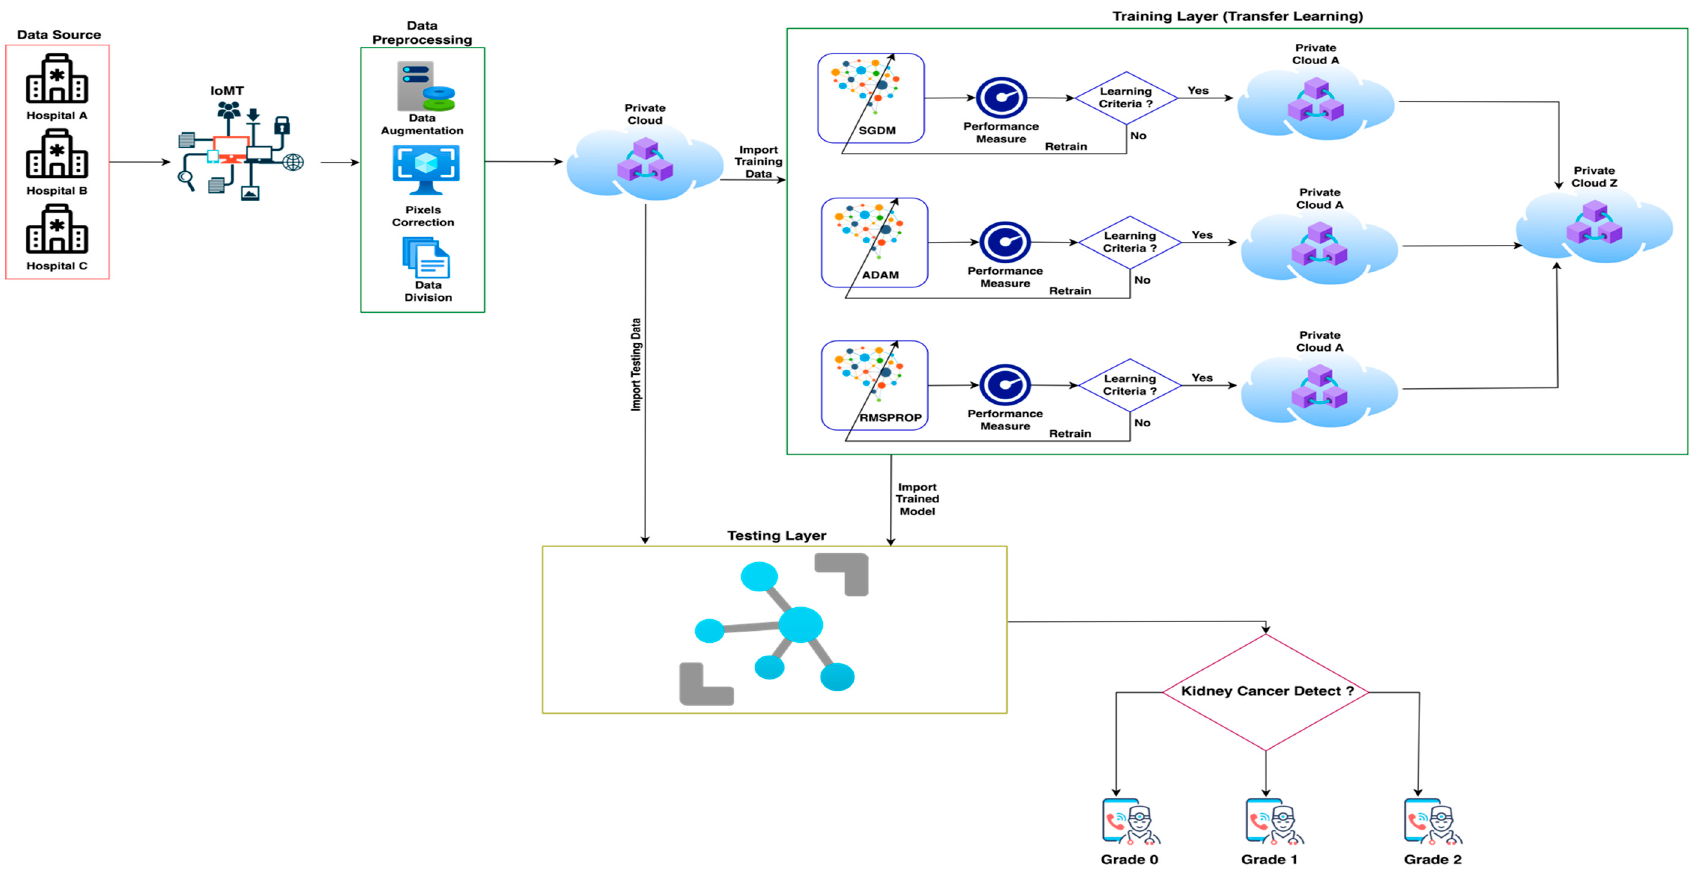
Figure 2. The proposed IoMT-based model for the prediction of kidney cancer empowered with blockchain security using transfer learning.